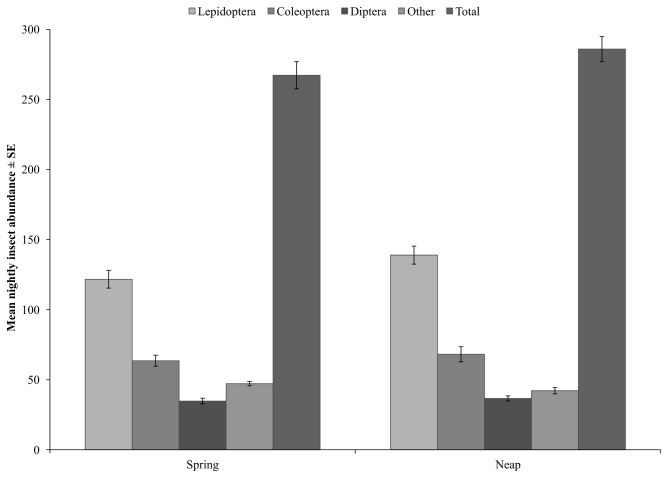
Nightly insect abundance.Insect abundance during spring and neap tides.